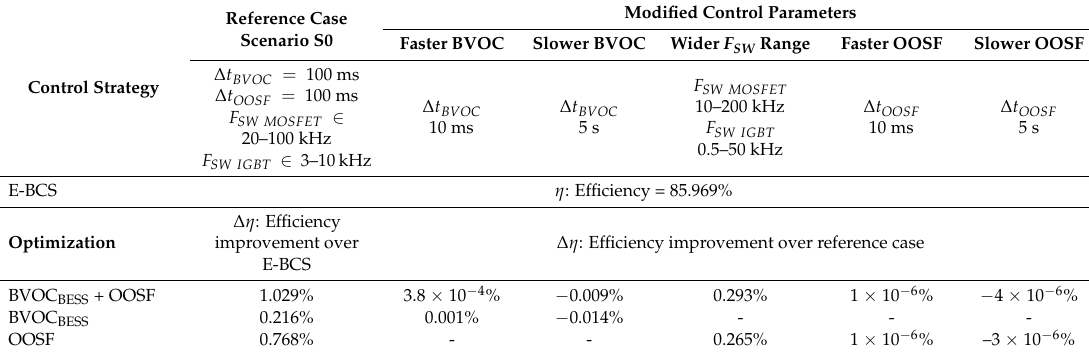
Table 4. Influence of control parameters on optimization